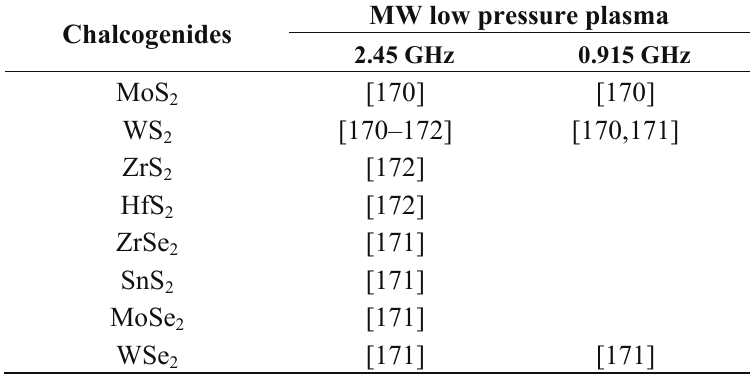
Table 4. Overview on published papers related to the subject of chalcogenide nanoparticles, synthesized in microwave